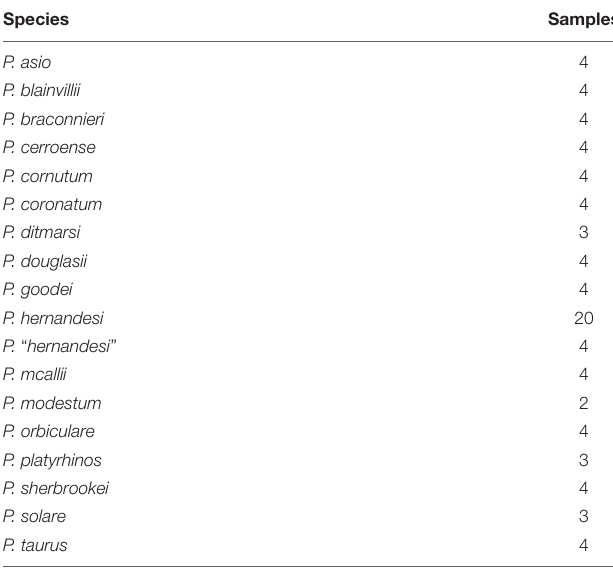
TABLE 1 | Species included in the reference-based taxonomic analysis of Phrynosoma. Species